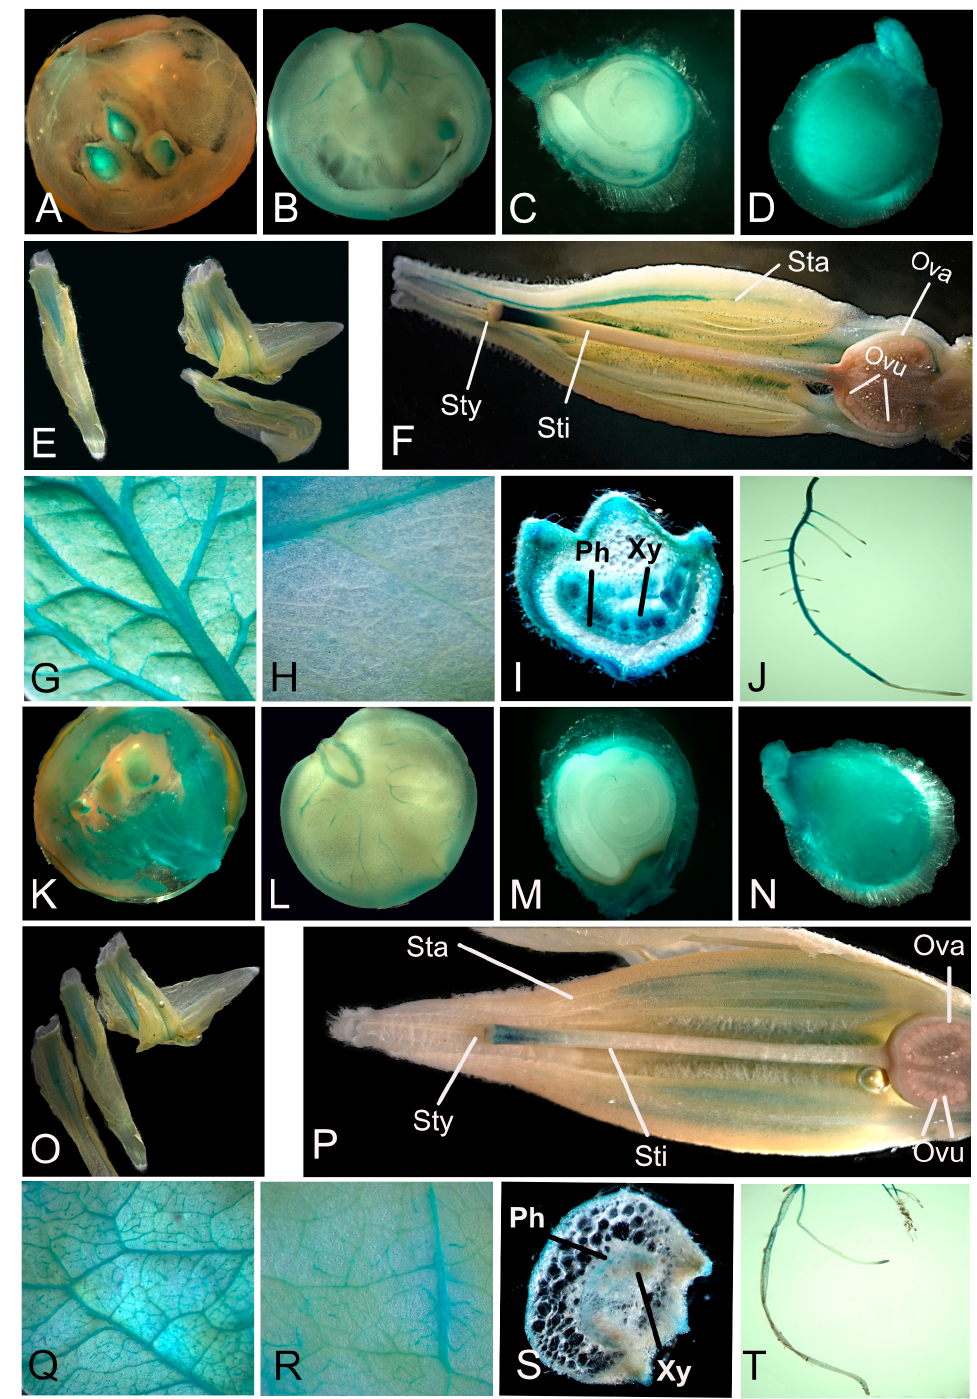
Figure 7. Promoter—GUS analysis of SlTPS2 and SlTPS8 expression ( A – J ) pSlTPS2::GUS . ( K – T ) pSlTPS8::GUS. Sty = style; Sti = stigma; Sta = stamen; Ova = ovarium; Ovu = ovule; Ph = phloem; XY = xylem. For each tissue, at least four independent transgenic lines were analyzed. The experiment was carried out twice with independent batches of plants and representative pictures are shown here.